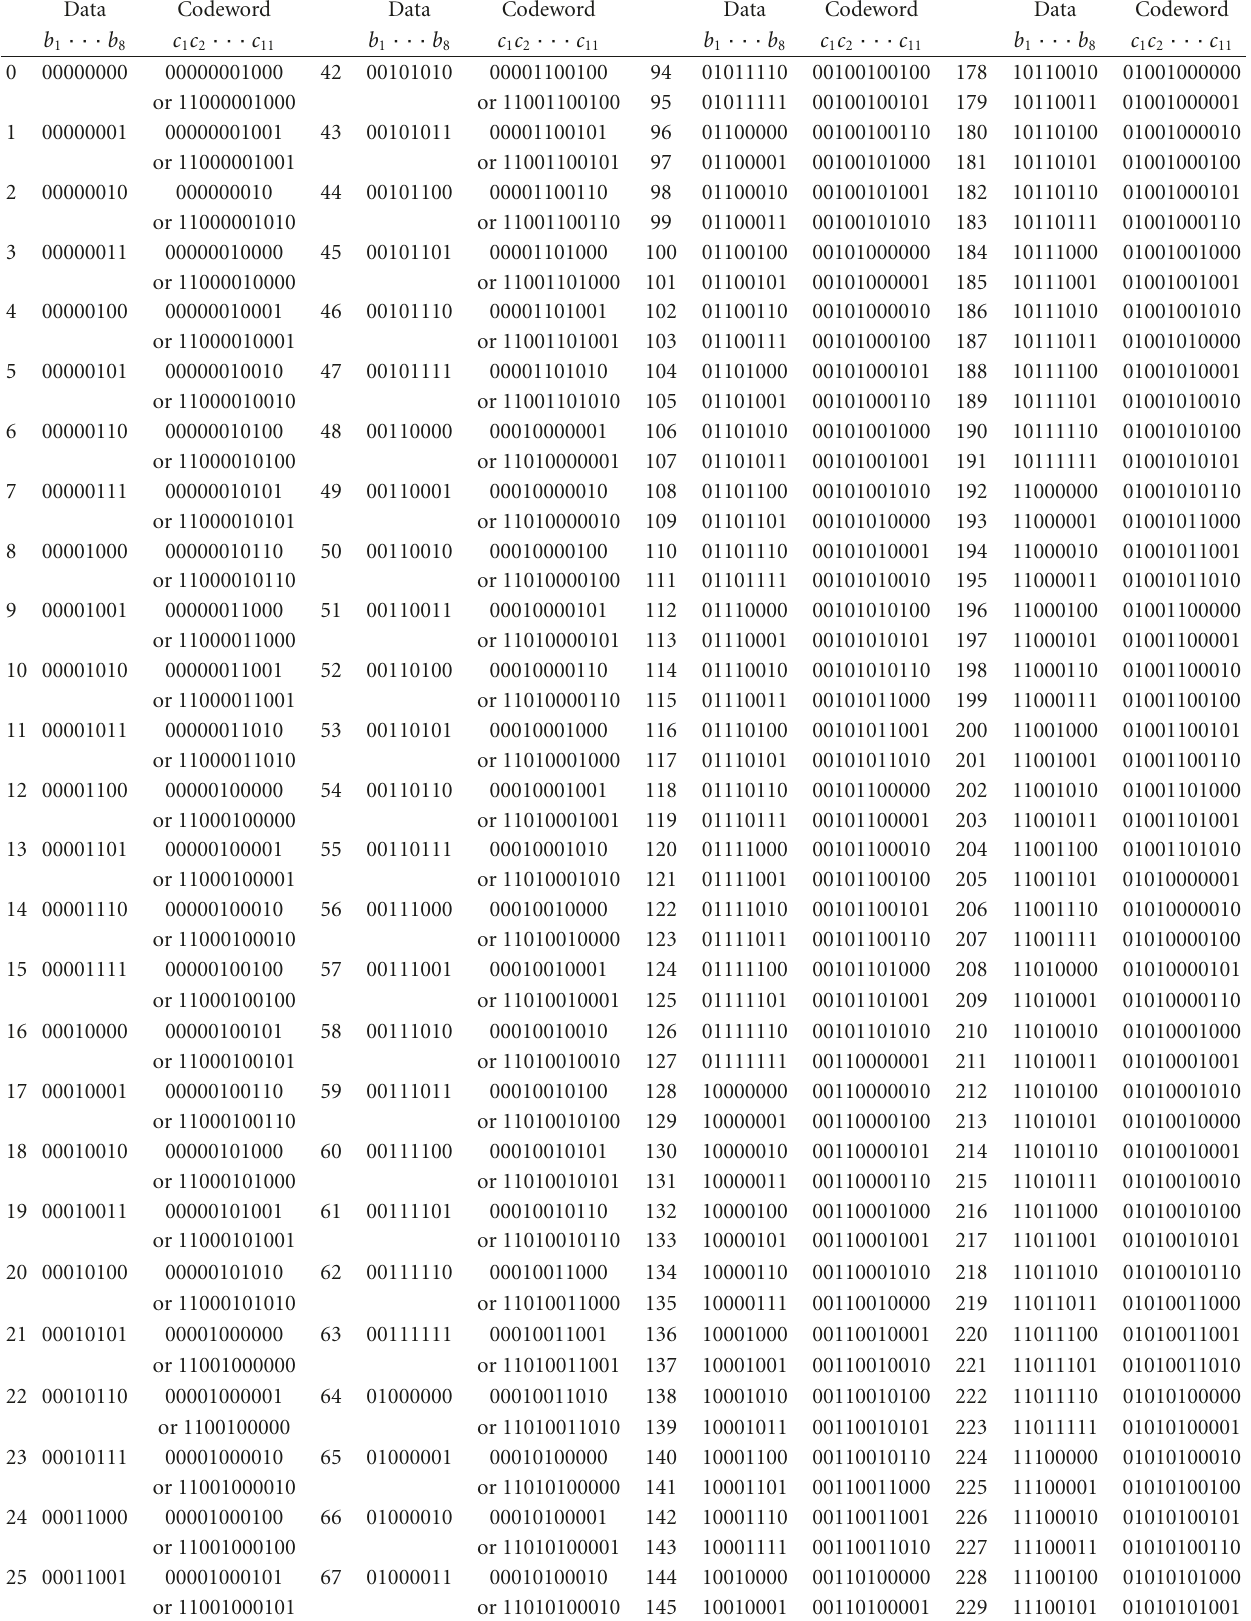
Table 3: Data to codeword mapping for the rate 8 / 11 ( k even 1 = 1, k odd 1 = 2, k = 7)